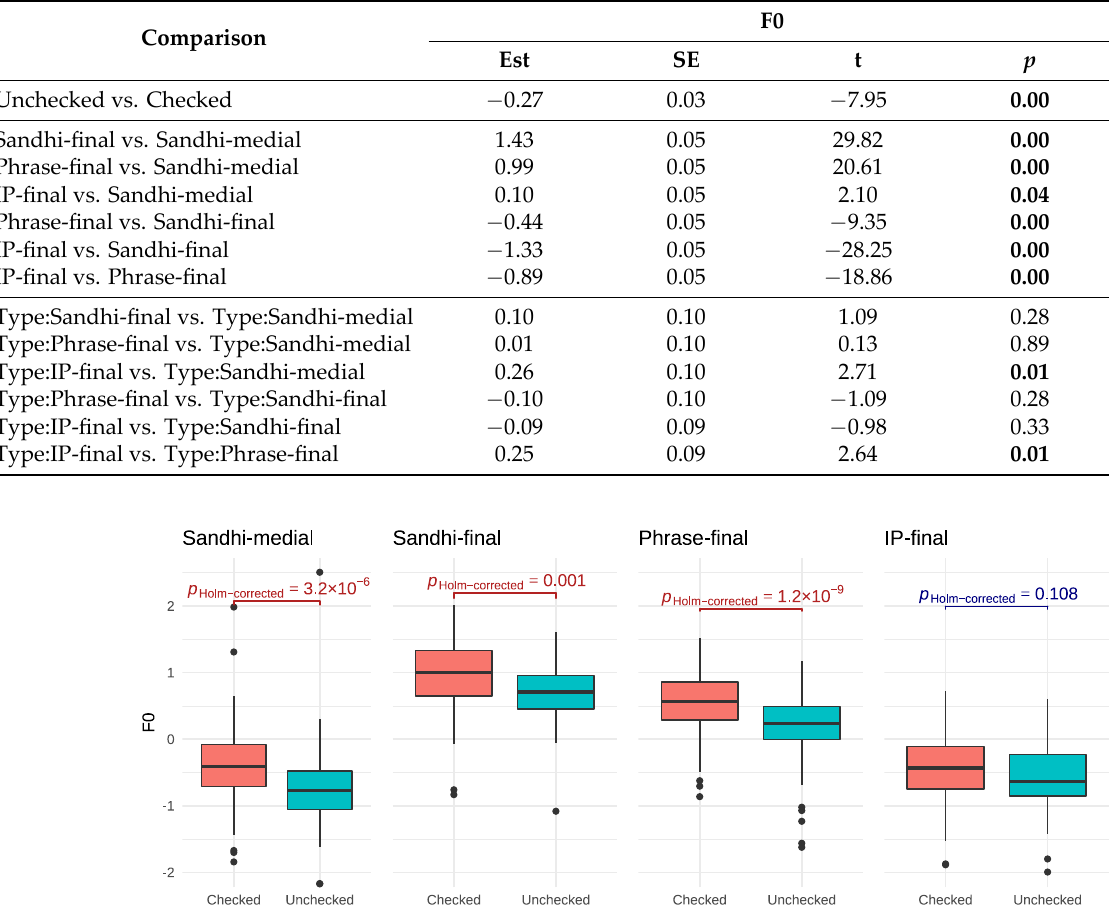
Table 6. Outputs of linear mixed‑effect regression for f0 with interaction as a fixed factor. Significant p ‑values ( p ⩽ 0.05 ) are marked in bold.